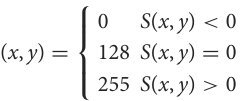
E (denoted as an event image) generated by the event-based